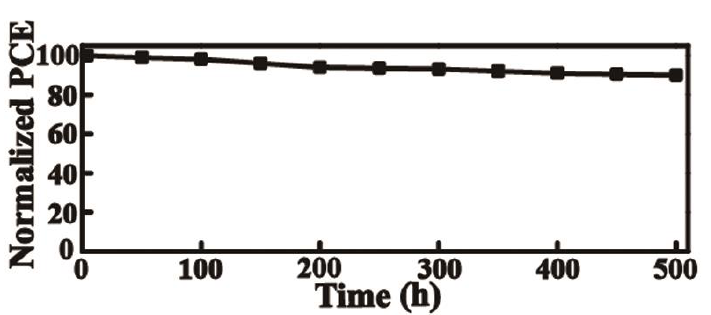
ffi ciency decay of perovskite solar Figure 7. The normalized efficiency decay of perovskite solar cells. Figure 7. The normalized e